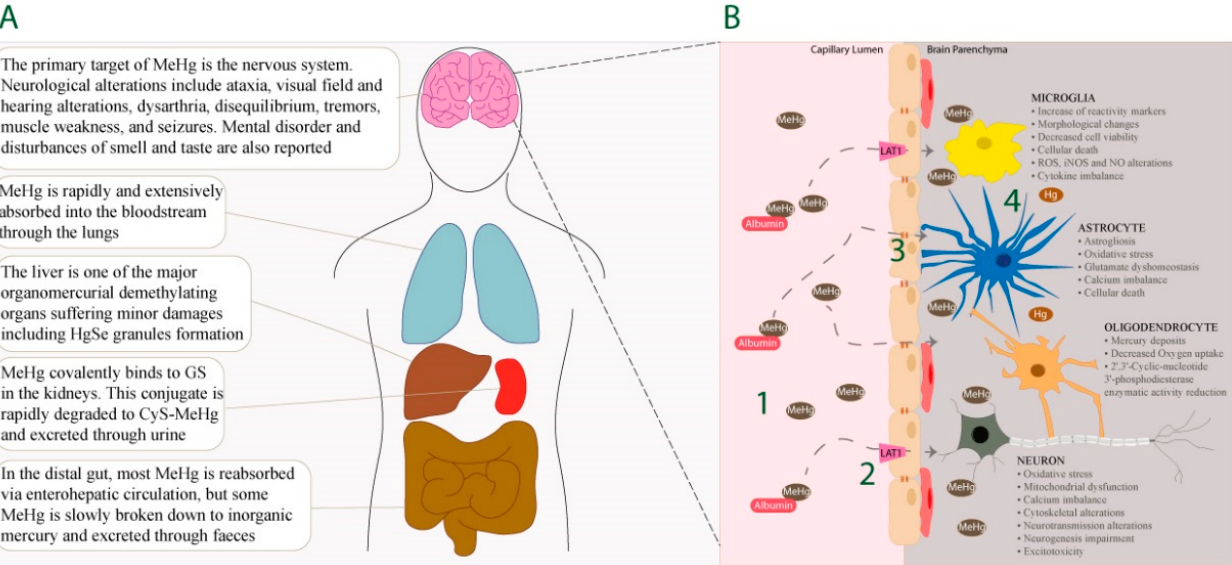
Figure 1. MeHg distribution across the body and main detrimental effects on the brain parenchyma. ( A ) The main organs affected by MeHg include the brain, liver, lungs, kidney, and intestines. ( B ) MeHg circulates in the bloodstream both freely and bound to albumin (1). After conjugating with L-cysteine, MeHg enters the endothelial cells via the LAT1 system (2) to finally cross the BBB (3). Once in the brain parenchyma, MeHg exerts its deleterious effects on neuronal cells and may be demethylated to inorganic Hg (4).